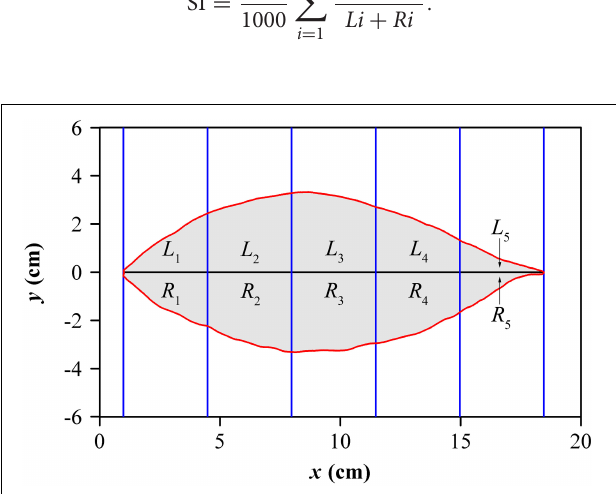
FIGURE 3 | Illustration for lamina bilateral asymmetry measure. For clarity, five equidistant strips are exhibited here, but 1000 strips were used in the actual